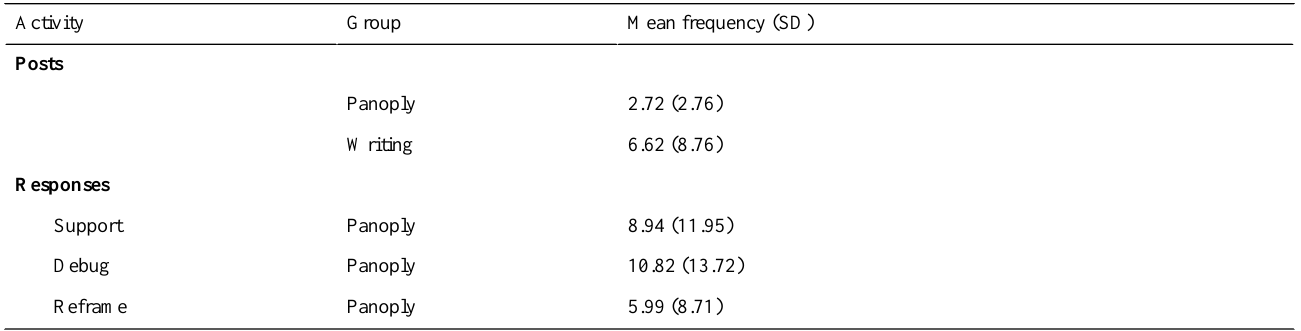
Table 3. Average usage patterns for the Panoply and expressive writing apps for 3